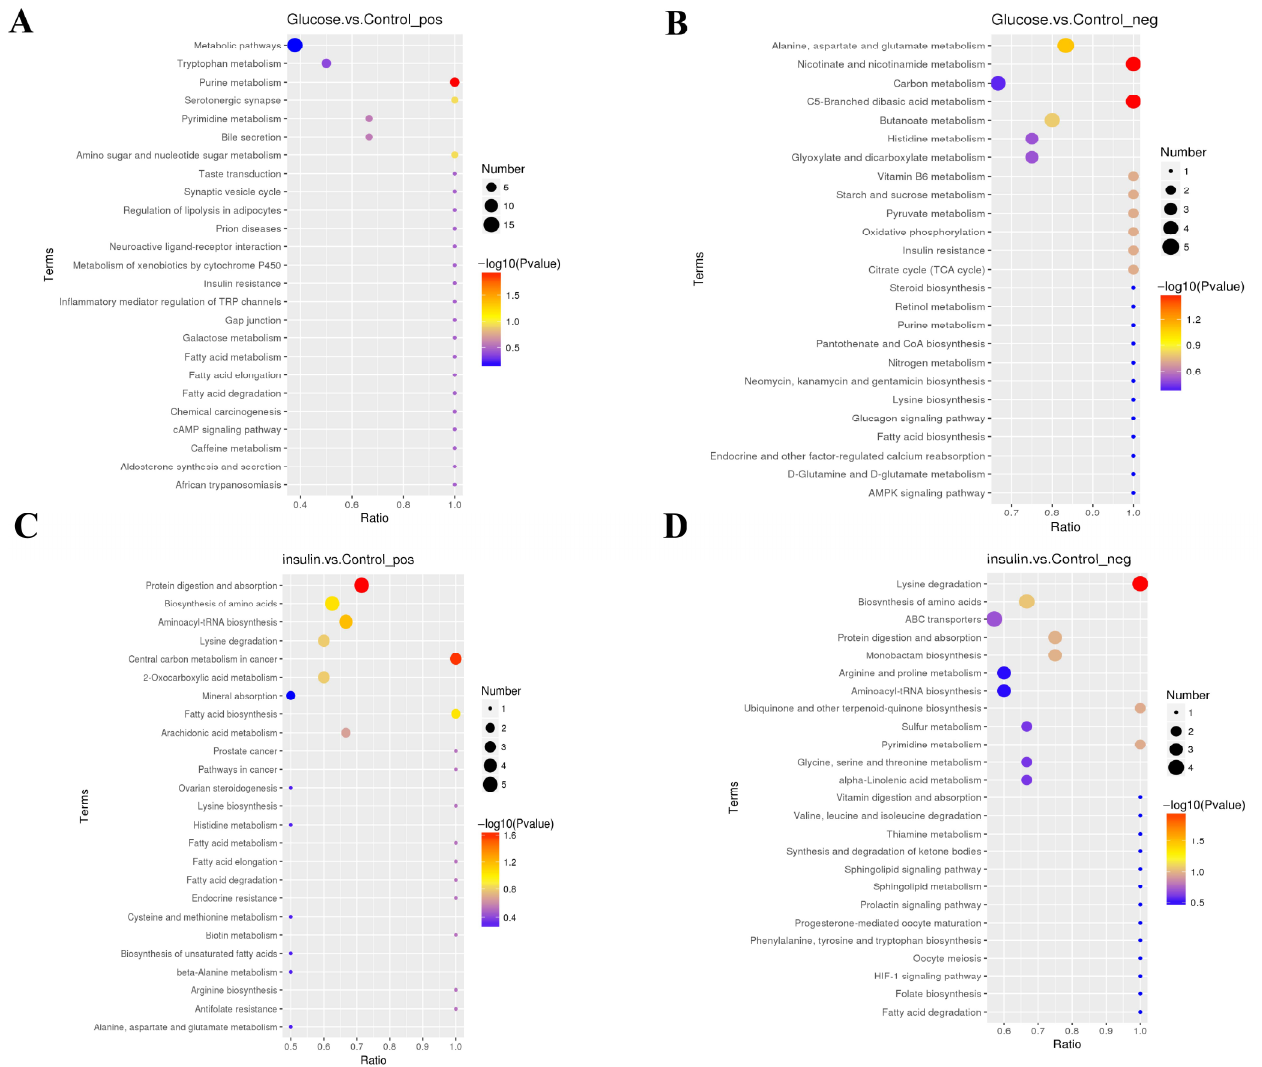
Figure 6. KEGG Enrich scatterplot of acute hyperglycemic/hypoglycemic chickens and control birds.